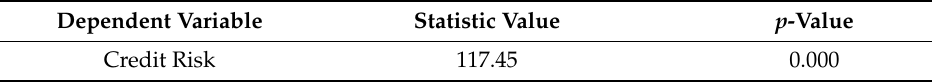
Table 6. Breusch and Pagan Lagrange multiplier test.